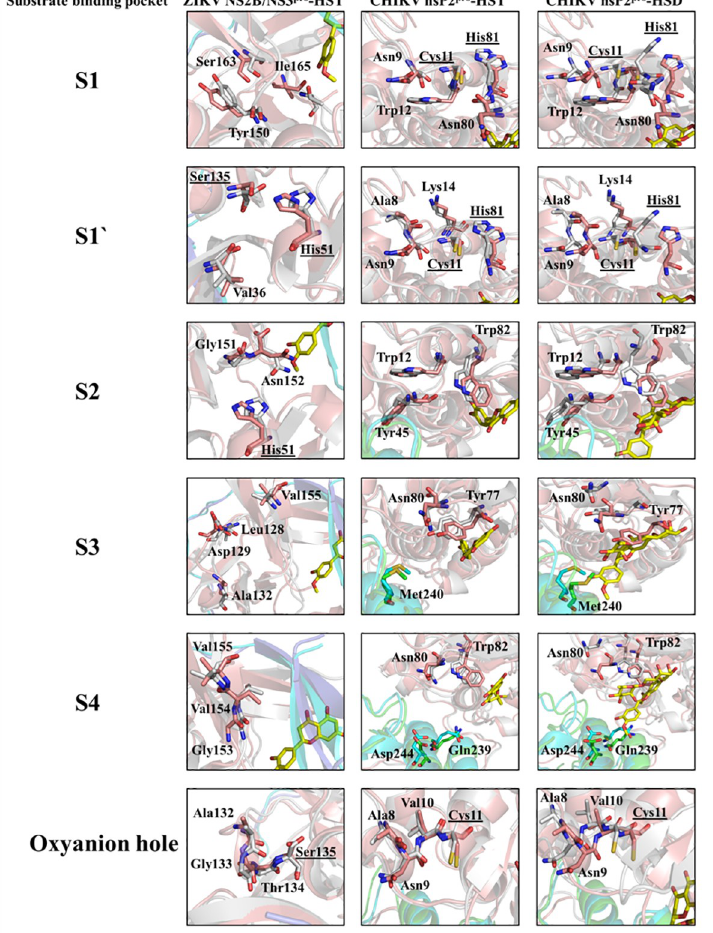
Fig 7. Substrate binding pockets and oxyanion hole of ZIKV NS2B/NS3 pro and CHIKV nsP2 pro (S1, S1´, S2, S3, S4) under the influence of HST and HSD. Structural overlay with the native protein structures, the active site residues are highlighted. The amino acid residues and the inhibitors are shown in